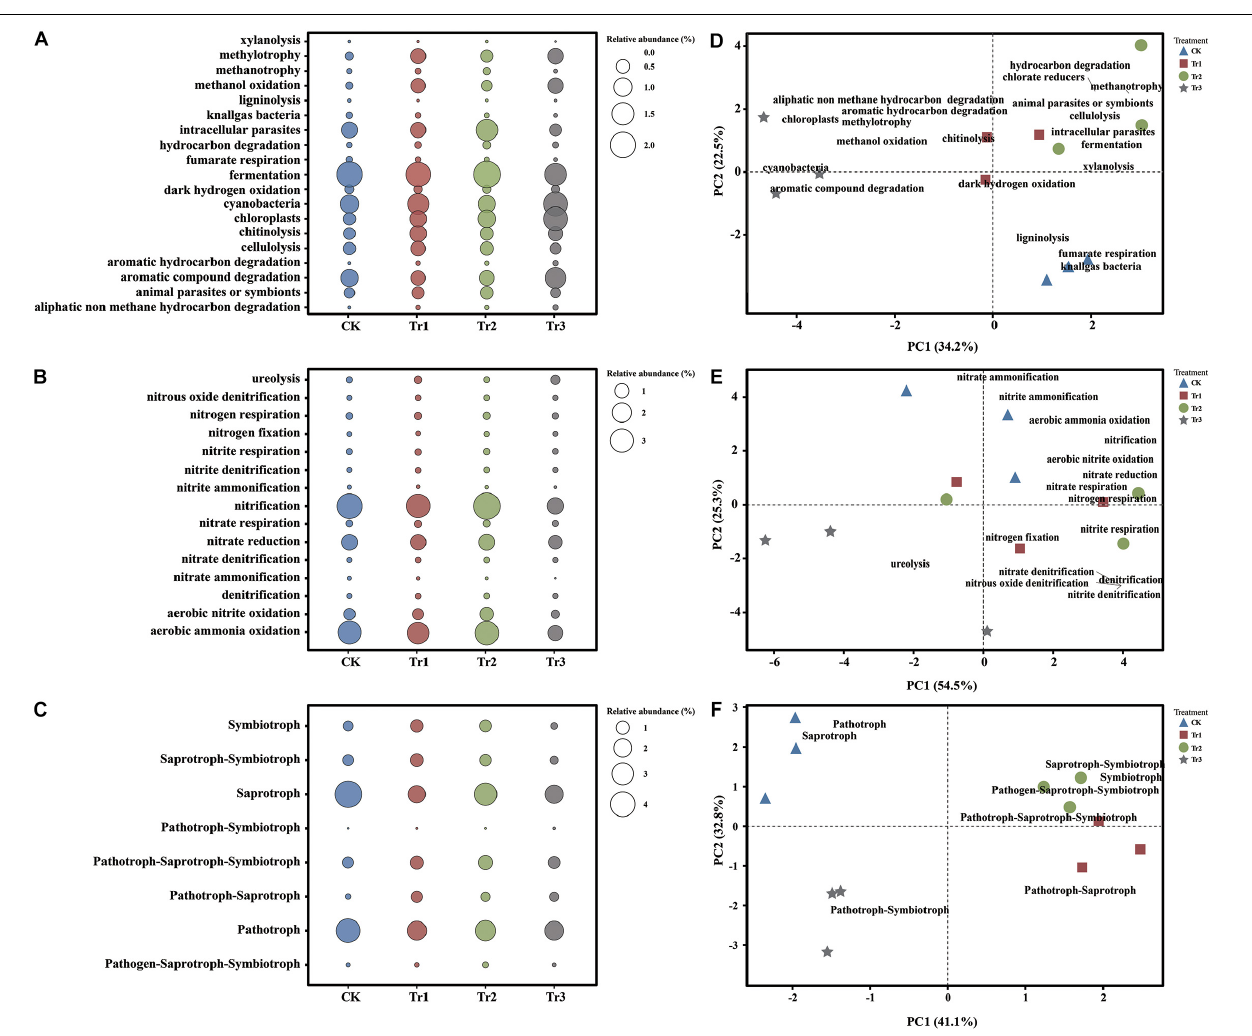
FIGURE 4 | Functional groups in soil with different species of intercropped aromatic plants, identified based on the OTUs obtained from 16S rRNA sequencing. Panels (A) , (B) , and (C) show the changes in functional groups related to the C and N cycles of the bacterial community and the trophic pattern of the fungal community. Panels (D) , (E) , and (F) show the functional group structure related to the C and N cycles of the bacterial community and the trophic pattern of the fungal community.